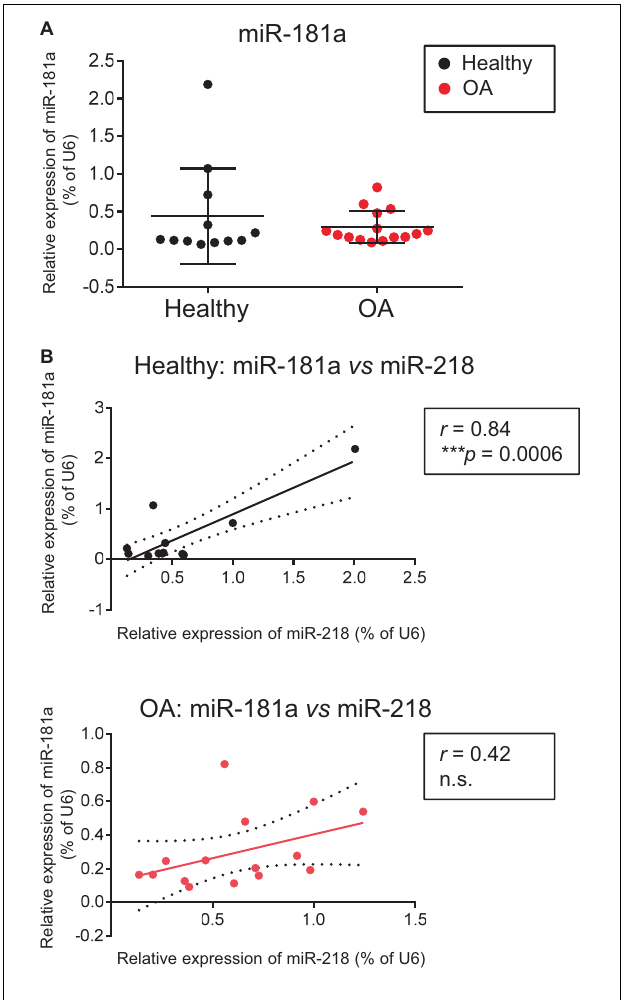
FIGURE 6 | There were no differences in miR-181a expression levels between healthy and OA cartilage, however, a tight correlation between miR-181a and miR-218 in healthy cartilage tissue was lost in OA cartilage. (A,B) Levels of expression for indicated miRs were measured in knee cartilage tissue isolated from 12 healthy (black) and 15 osteoarthritis (OA, red) donors by qRT-PCR and normalized to U6. Horizontal lines are set at median values. Linear regression is depicted with a solid line, and 95% confidence intervals are depicted with dotted lines in (B) ; r , Pearson correlation coefficient; ***p ≤ 0.001; n.s., not significant.